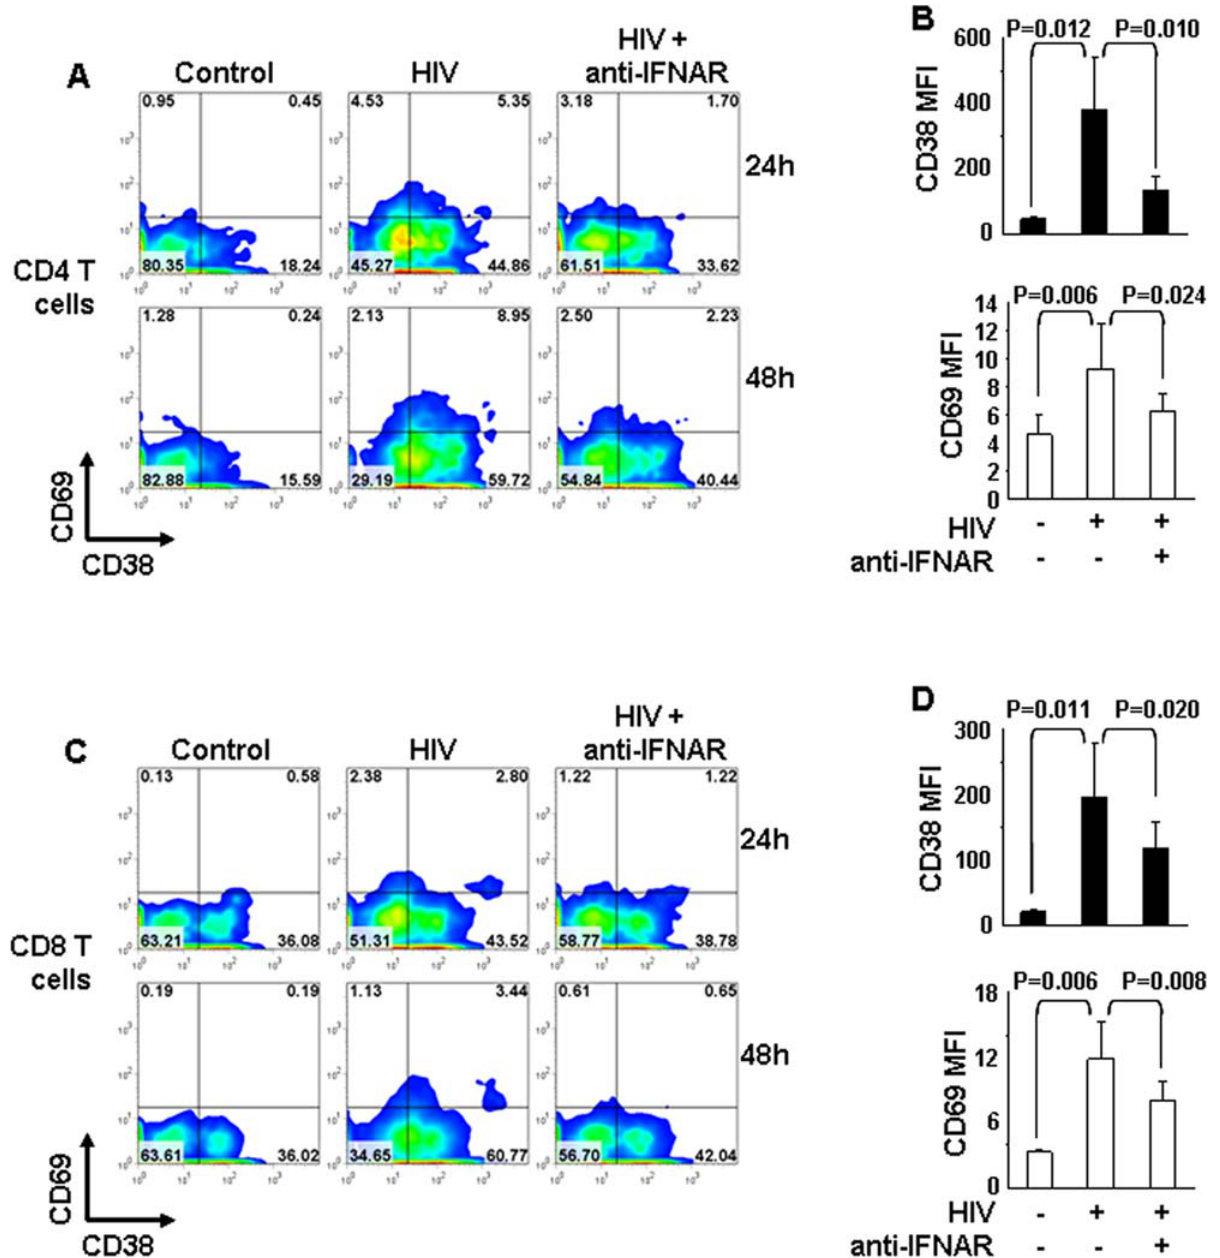
anti-CD3 (OKT-3) and anti-CD28 antibodies (complete absence of pDC from CD4 T cells is shown in Supplemental Figure